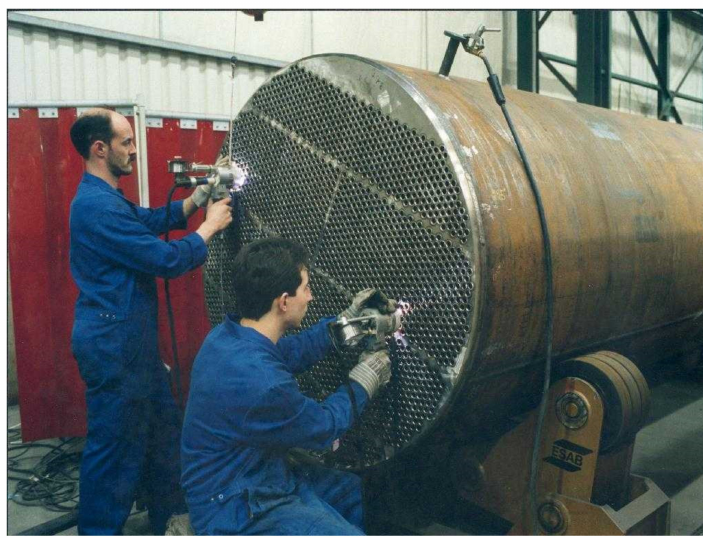
Figure 15. Superduplex heat exchanger for the HCL column intercooler in a VCM plant.